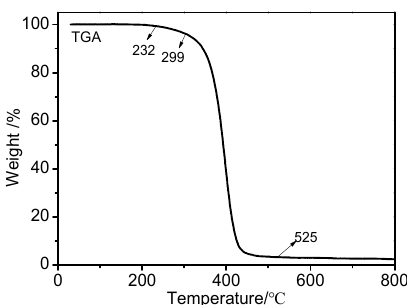
Figure 11. TG (10 °C/min) curve of OFAE-SA-BA under